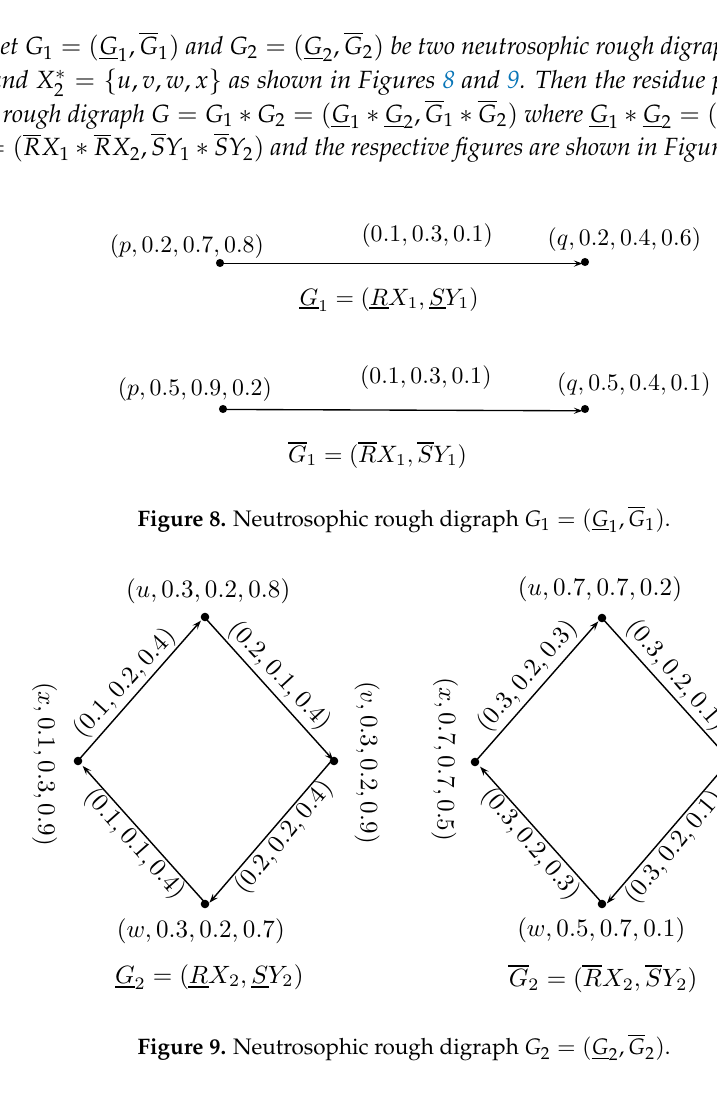
Figure 9. Neutrosophic rough digraph G 2 = ( G 2 , G 2 ) .